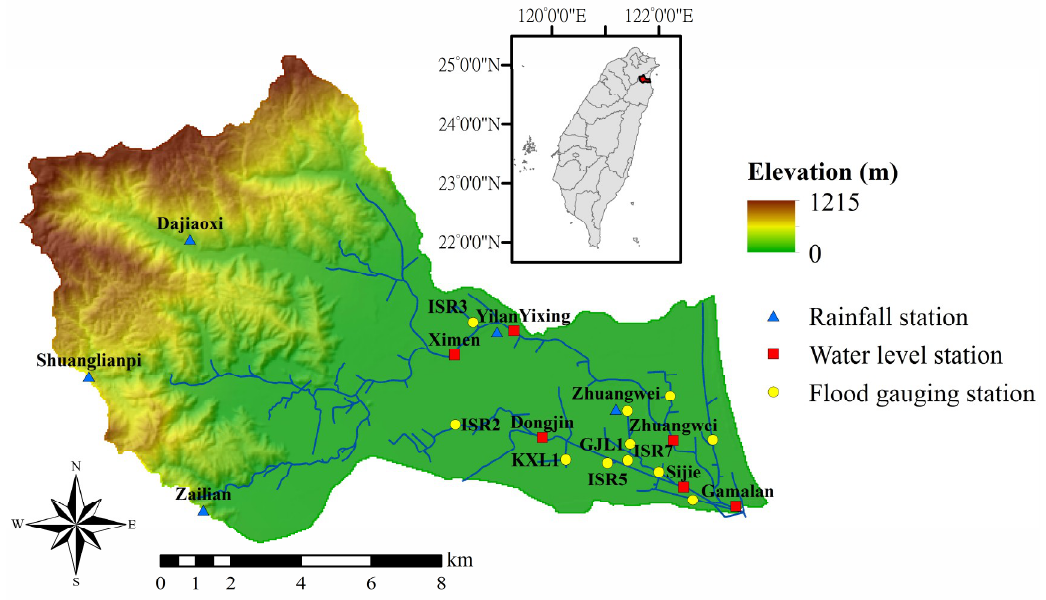
Figure 1. The Yilan River basin and the locations of rainfall, water level and flood gauging stations. Table 1. Hydrological and inundation data for typhoons from 2004 to 2015.